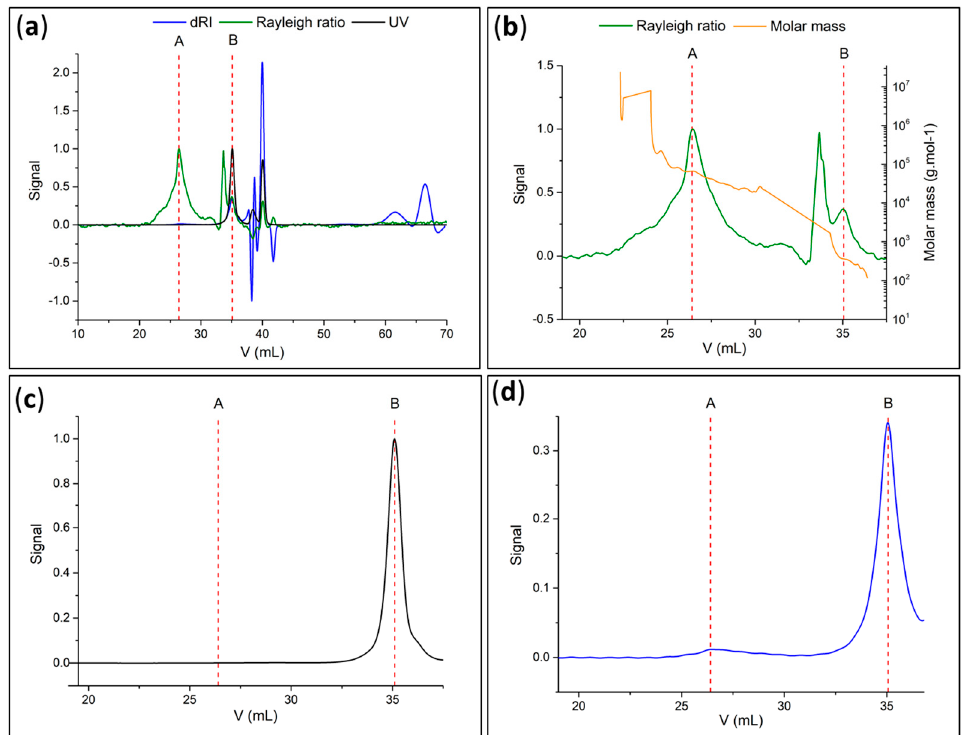
Figure 11. ( a ) Chromatogram of photocleaved PMMA recovered in solution (green: Rayleigh ratio or light-scattering signal; blue: refractometer signal; black: UV at 254 nm); ( b ) molar mass (green: light-scattering signal; orange: molar mass); ( c ) signal in UV at 254 nm and ( d ) refractometer signal of photocleaved PMMA recovered in solution.